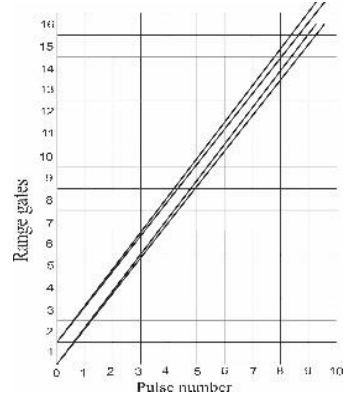
Figure 6– Target migrations through the range cells Рис. 6 – Миграция цели по ячейкам диапазона Слика 6 – Миграција циља кроз резолуционе